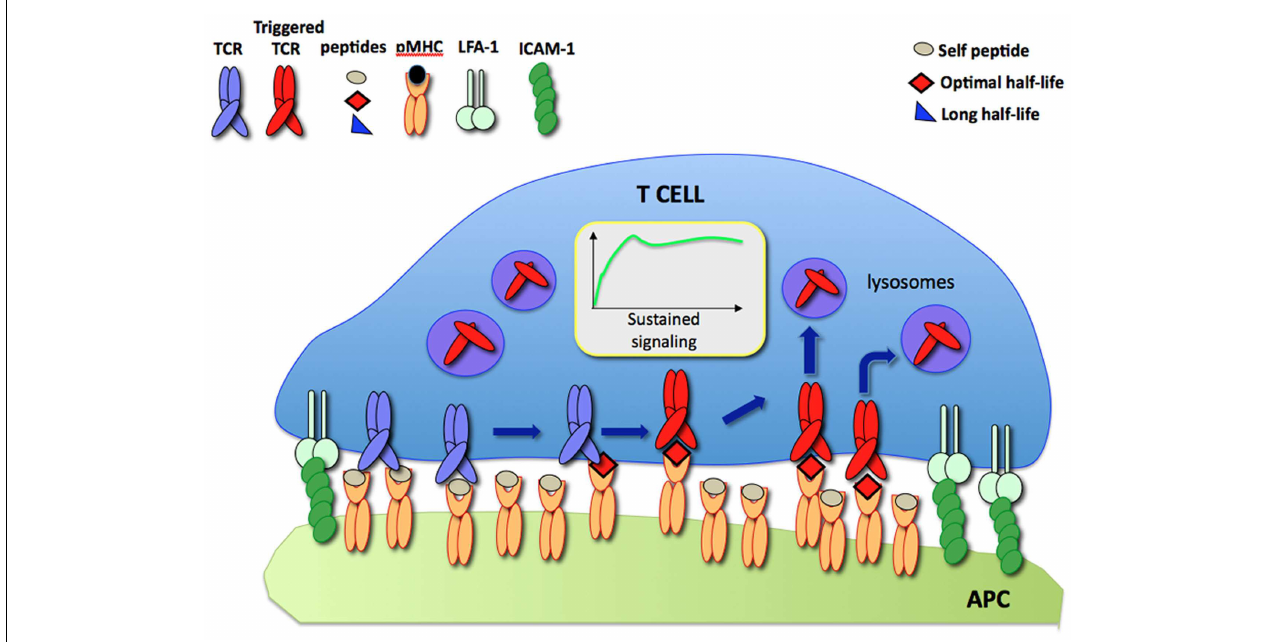
FIGURE 1 |The serialTCR engagement model. At the IS, a few specific pMHC (red) sequentially trigger incomingTCR resulting in sustained signaling. TriggeredTCR are internalized and targeted to lysosomes for degradation while unbound pMHC bind newTCR.